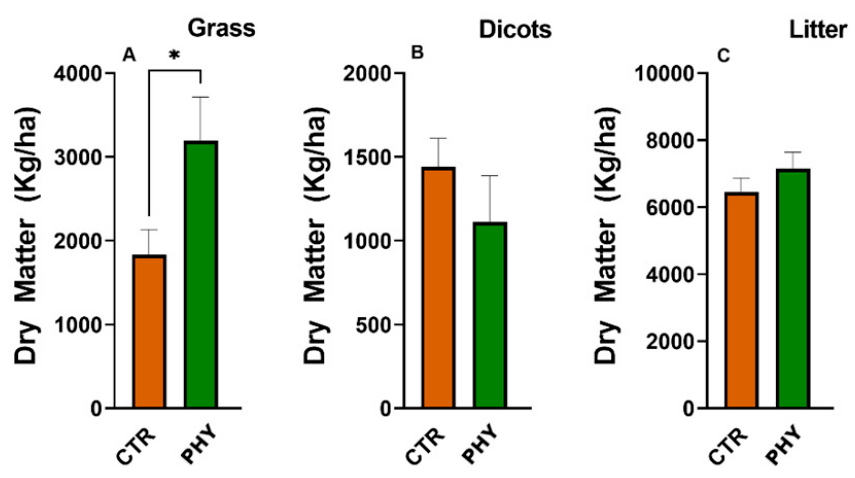
Figure 9. Dry matter differences between phytogenic liquid-treated and control plots 18 months post-application for grass ( A ), dicots ( B ) and litter ( C ). The asterisk indicates significant change (* = p < 0.05).